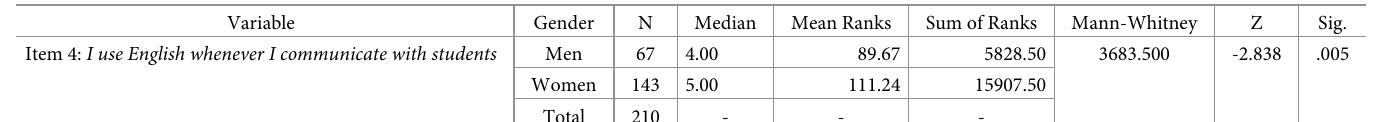
Table 8. Mann-Whitney test.